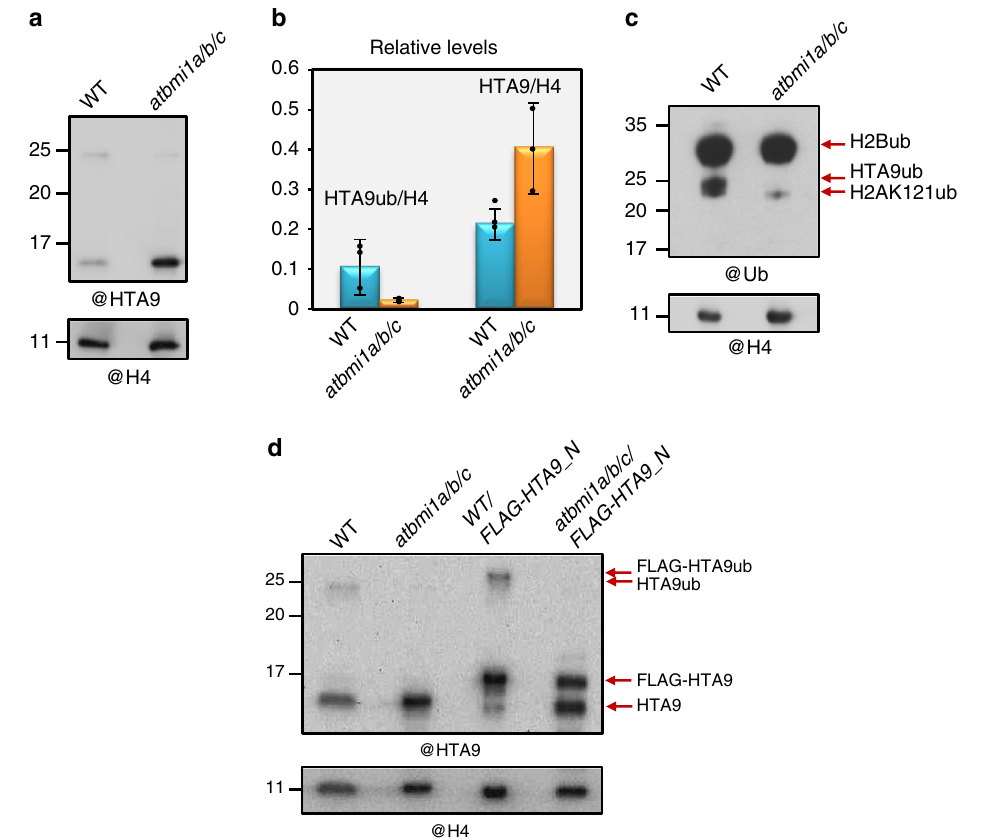
Fig. 2 The AtBMI1 proteins mediate H2A.Z monoubiquitination. a Western blot (WB) analysis of HTA9 levels in histone-enriched extracts of wild-type (WT) and atbmi1a/b/c mutant at 7 days after germination (DAG). The same blot was probed with anti-H4 antibody for loading control. b Quanti fi cation of HTA9 and HTA9ub levels in WT and atbmi1a/b/c mutant relative to H4; Error bars indicate standard deviation of n = 3 independent experiments. Data points are indicated in the bar charts. c WB analysis of WT and atbmi1a/b/c mutant histone-enriched extracts at 7 DAG probed with anti-ubiquitin antibody. Bands corresponding to H2Bub, H2AK121ub, and HTA9ub are indicated. A blot probed with anti-H4 antibody was used as a loading control. d WB analysis of HTA9 and FLAG-HTA9 levels in WT, atbmi1a/b/c , WT/FLAG-HTA9_N , and atbmi1a/b/c/FLAG-HTA9_N . Arrows indicate the bands recognized by the antibody. The same blot was probed with anti-H4 antibody for loading control. Source data of Fig. 2a – d are provided as a Source Data fi